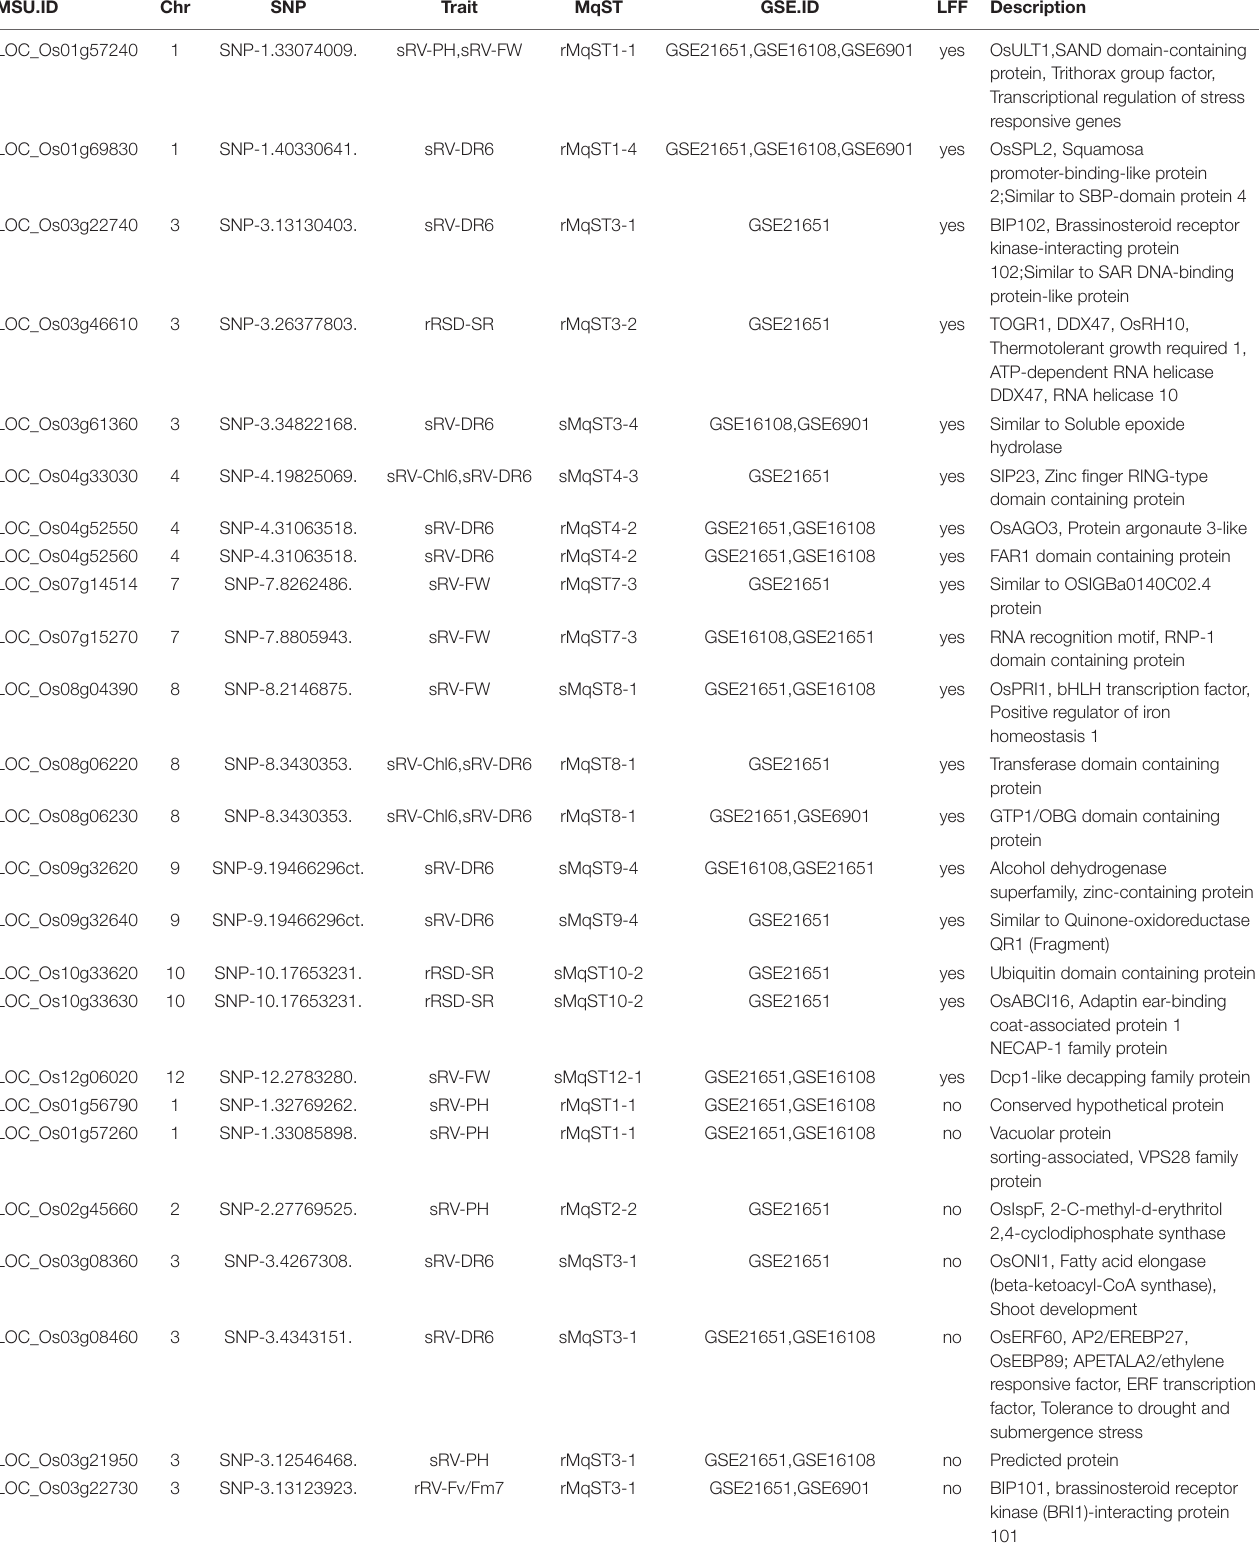
TABLE 1 | Details of candidate genes for salt tolerance and its co-located single nucleotide polymorphisms (SNPs) and meta quantitative ST loci (MqSTs).